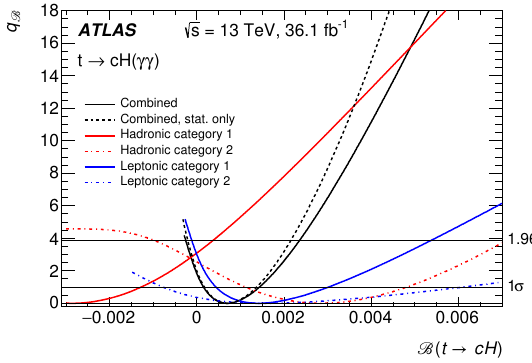
Figure 5. Observed evolution of q B (see text) as a function of the t ! cH branching ratio B . The dotted curve corresponds to the case where all constrained nuisance parameters are (cid:12)xed to their maximum-likelihood estimators at ^ B . The likelihood functions are only de(cid:12)ned for a positive number of expected events, hence the leptonic categories and combined curves do not cover the full scanned range. The intersection of the combined q B curve with the line at 1 : 96 (cid:27) gives the 95% CL upper limit in the asymptotic approximation.